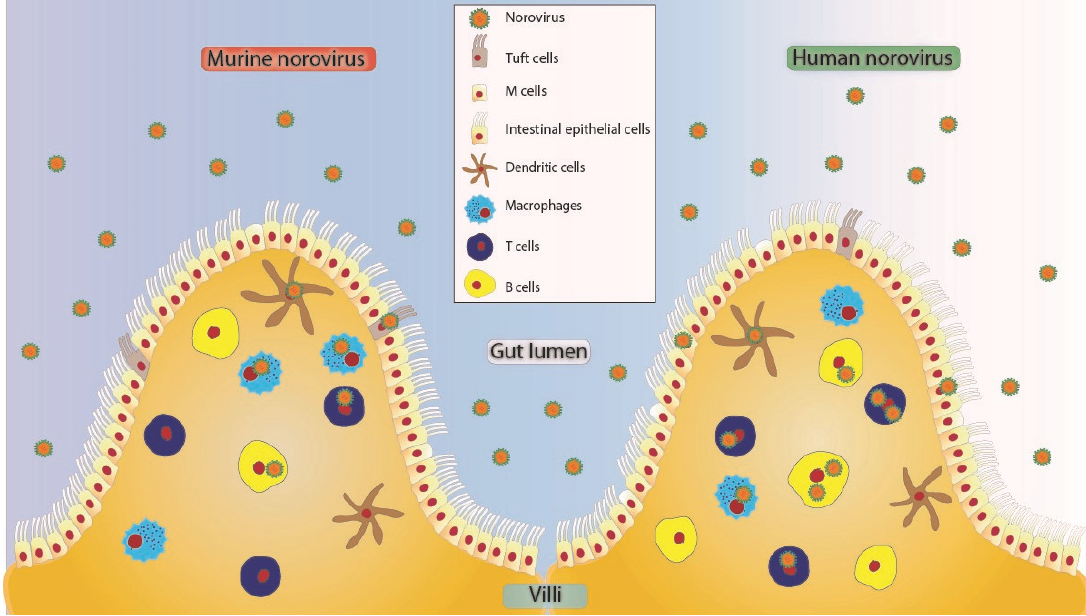
Figure 1. Proposed tropism model of MNV and HuNoV to various cells in the human small intestine [36,50]. These viruses may enter in free form or as clusters [51] potentially crossing through microfold (M) cells [52,53] or through intestinal epithelial cells of the villus. Tuft cells express CD300lf and have been shown to be infected by MNV [39]. Norovirus can further cross the brush border of epithelial cells to infect cells of hematopoietic origin like dendritic cells [36,43], T cells [14,36,41], B cells [36,43], and macrophages [14,36,41]. All the cell types depicted as HuNoV positive have been shown to be positive for viral antigen or genome in either animal studies or human studies.